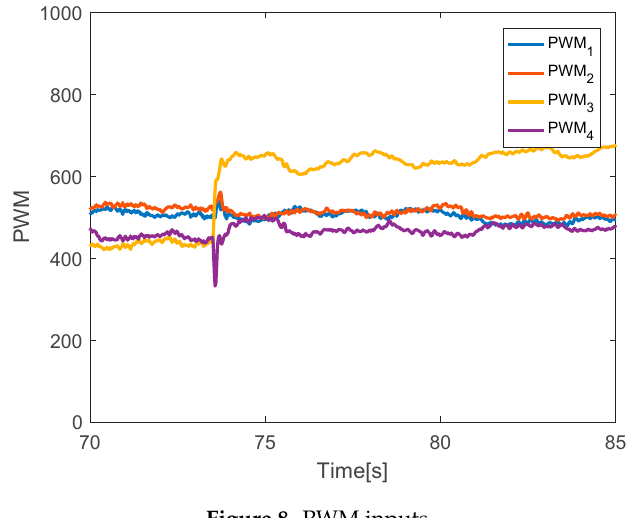
Figure 8. PWM inputs. Figure 8. PWM